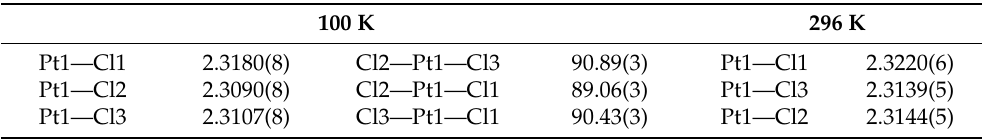
Table 2. Selected geometric parameters (Å, ◦ ) for I